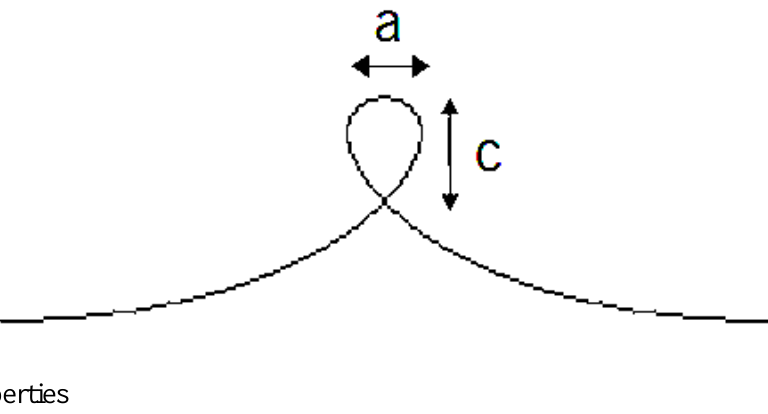
Figure 4. Loop test for compression. The ratio c/a changes at failure